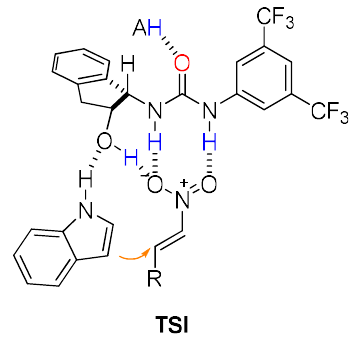
Figure 7. Proposed transition states for the [urea  acid]-catalyzed Friedel-Crafts reaction.